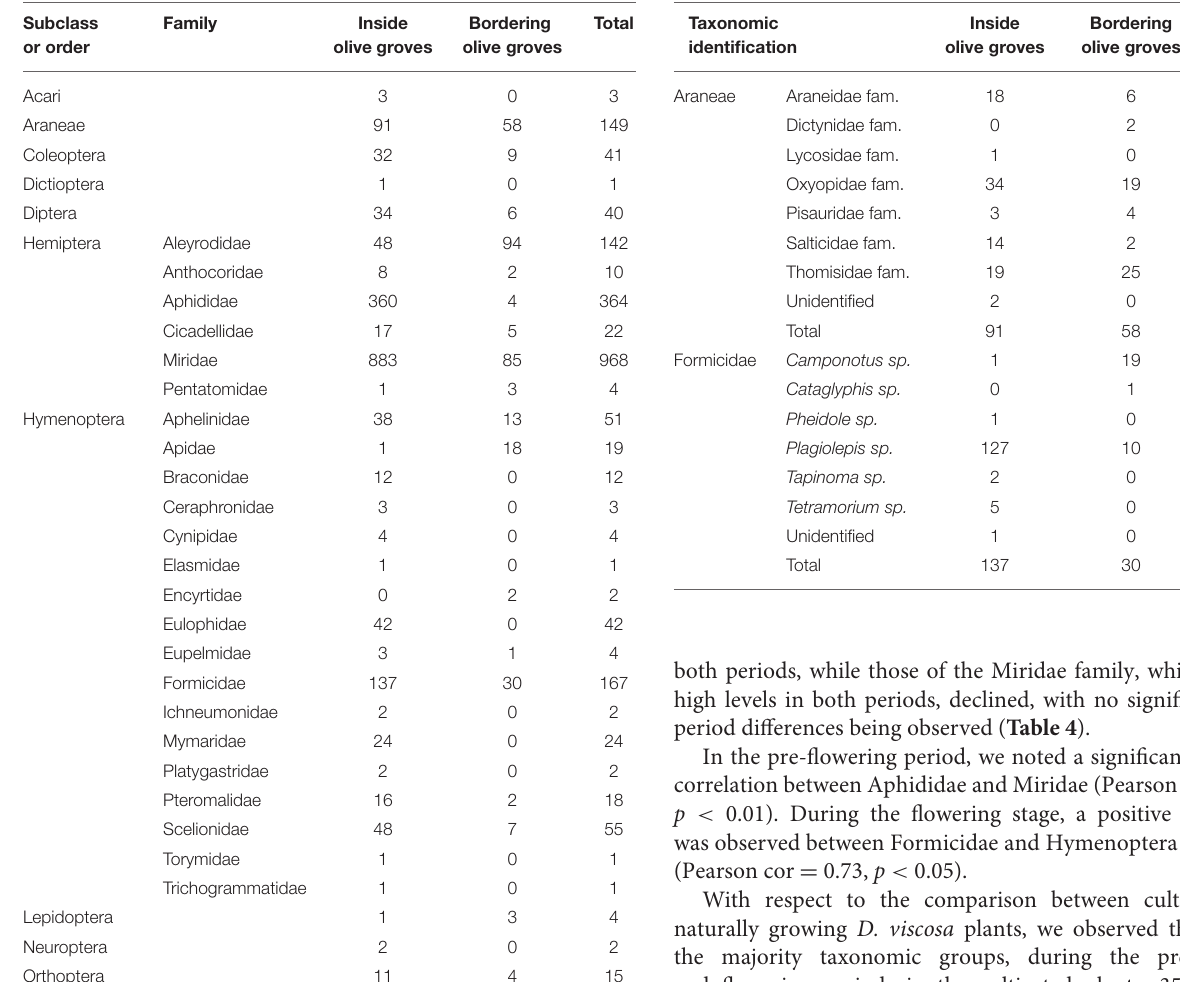
TABLE 1 | Number of individuals collected during sampling period in bordering and inside olive grove.